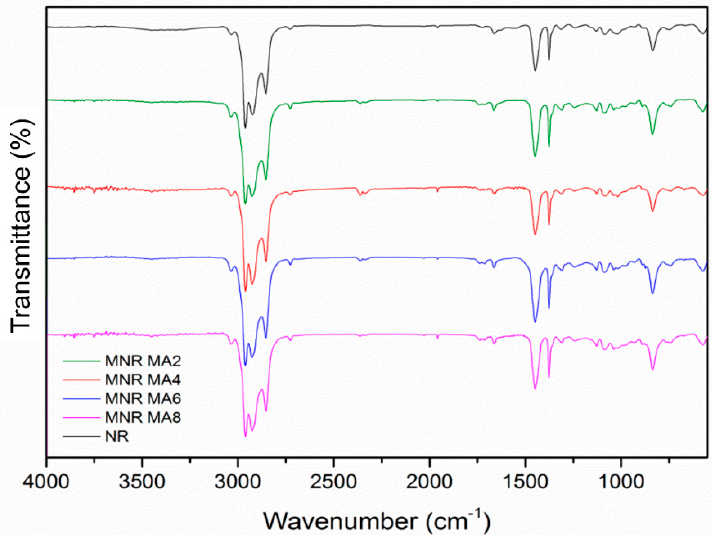
Figure 1. FTIR spectra of maleated natural rubber prepared at various maleic anhydride contents.